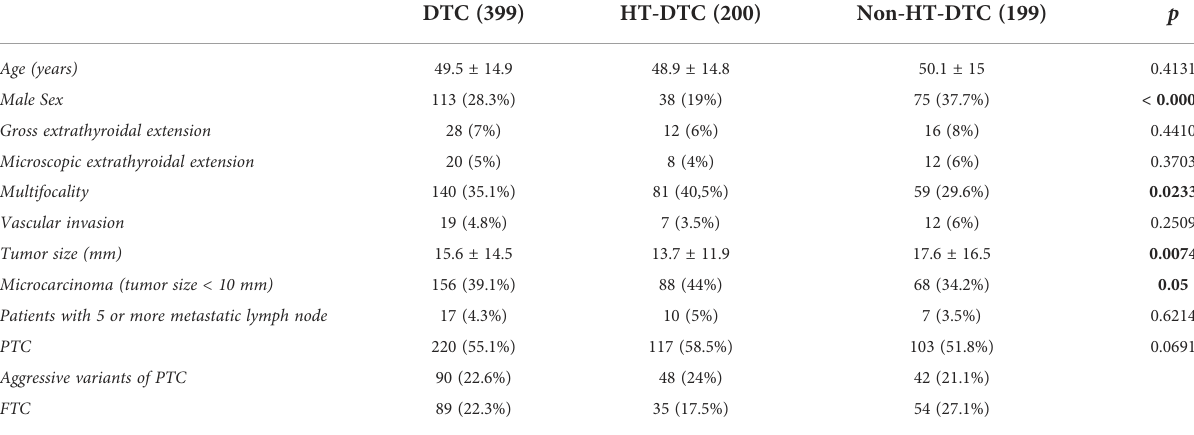
TABLE 3 Differentiated thyroid cancer patients.